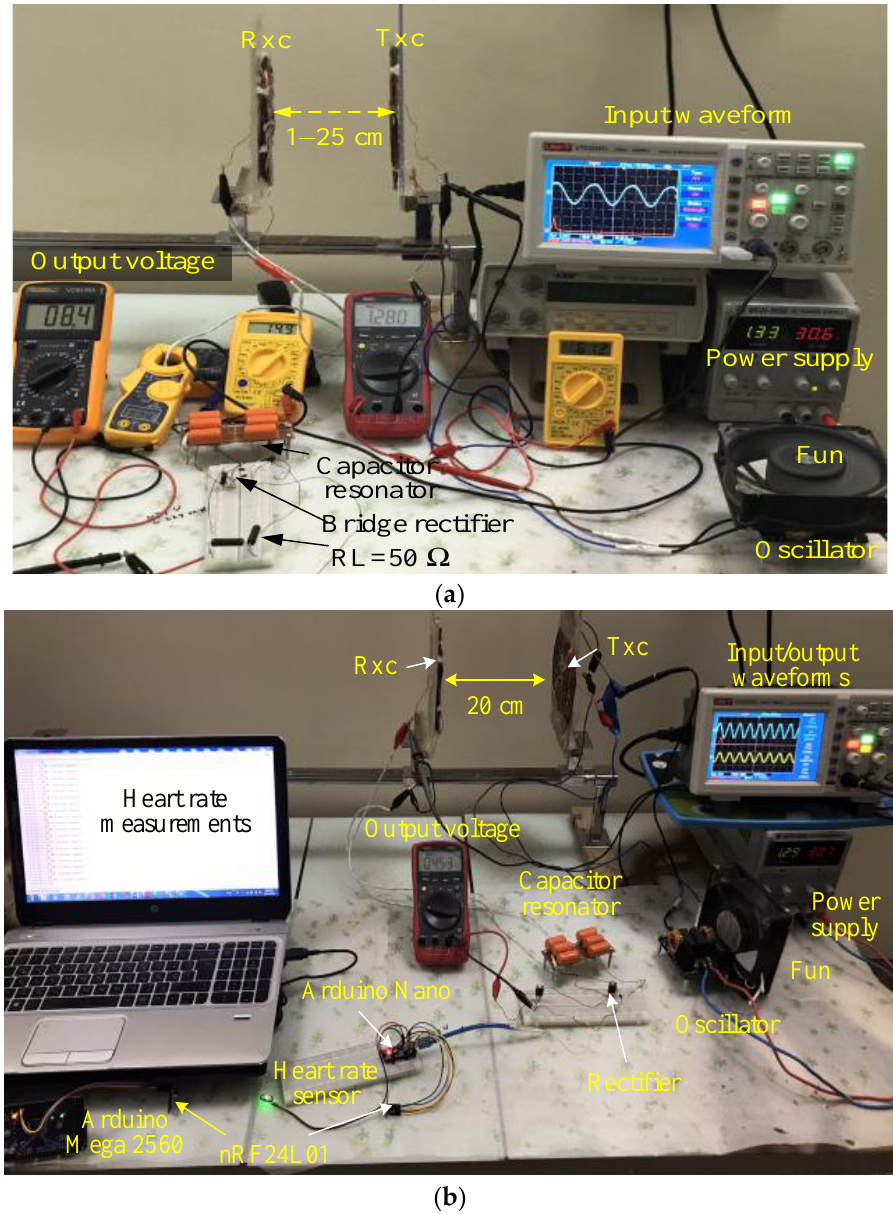
Figure 4. The experiment of ( a ) explores the key parameters of the MRC-WPT-based WHR monitoring system and ( b ) WHR measurement at 20 cm.